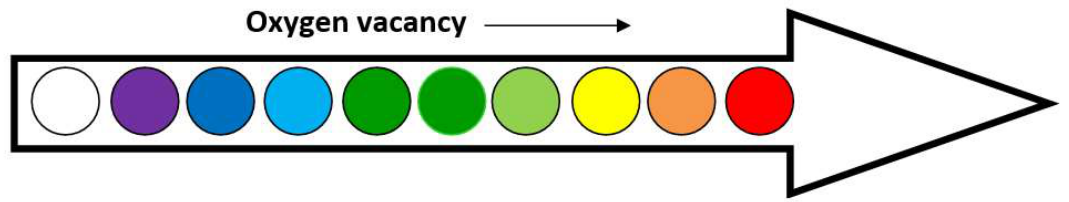
Figure 8. Enhancement of visible absorption with increasing oxygen vacancy.